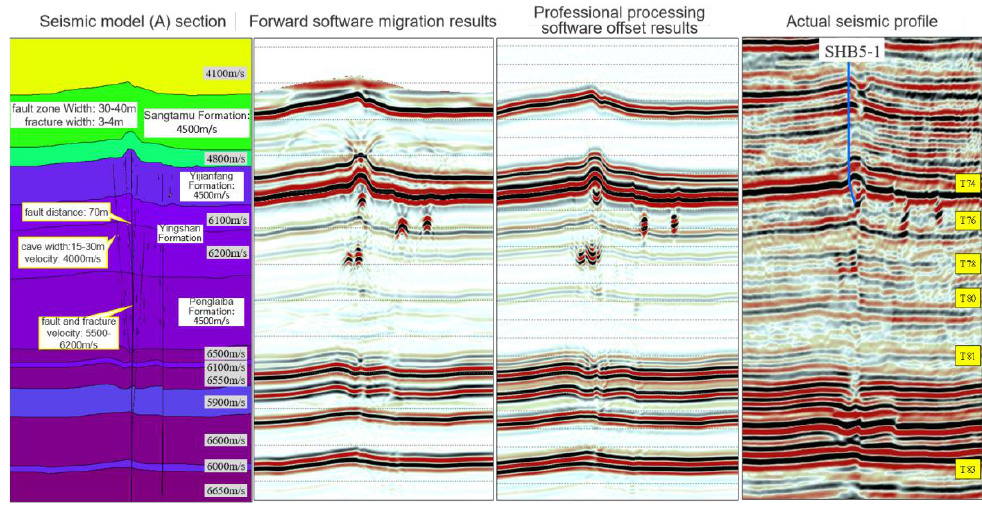
Figure 11. A comparison between the migration result of the forward model A and seismic profile of actual drilling. actual